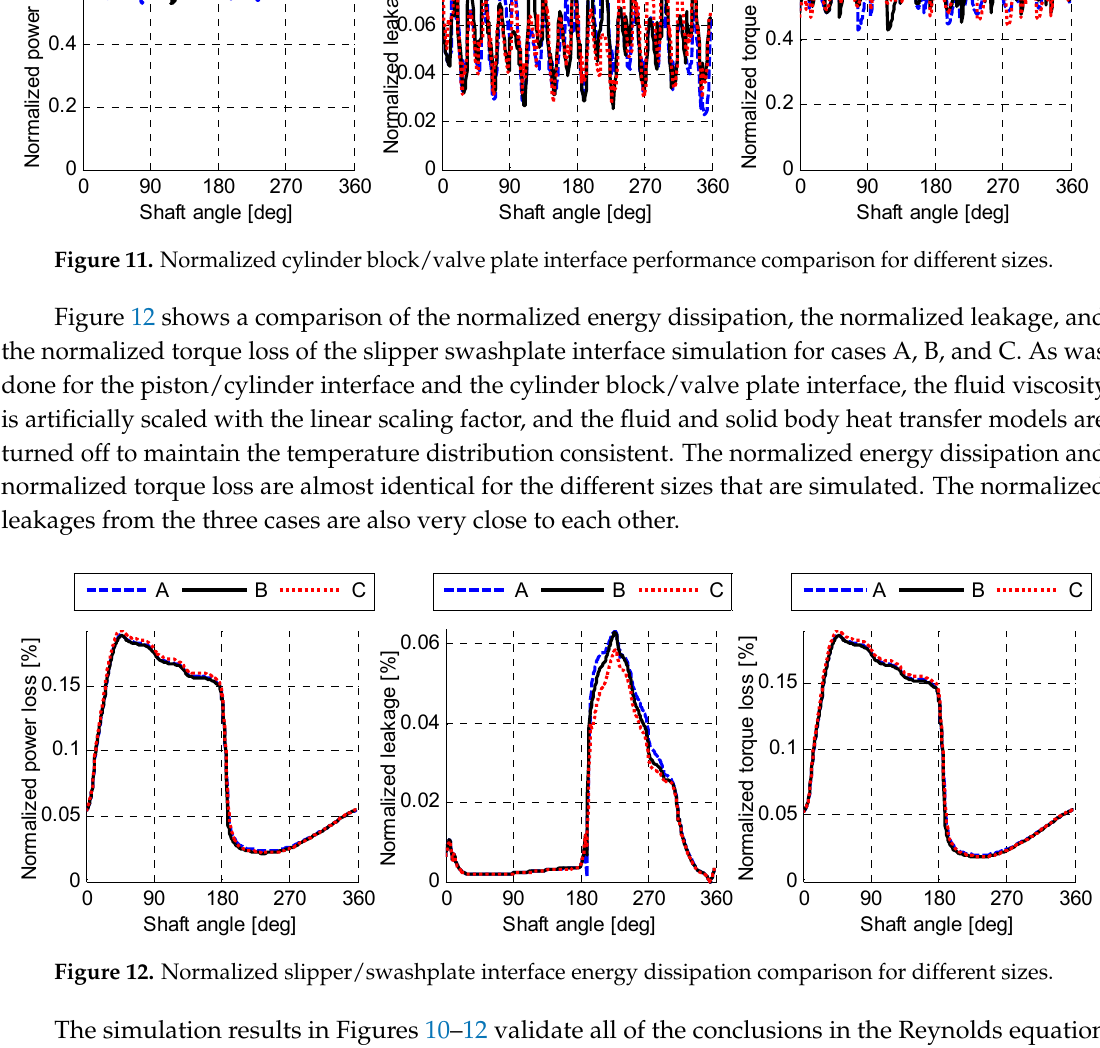
Figure 12. Normalized slipper/swashplate interface energy dissipation comparison for different sizes.